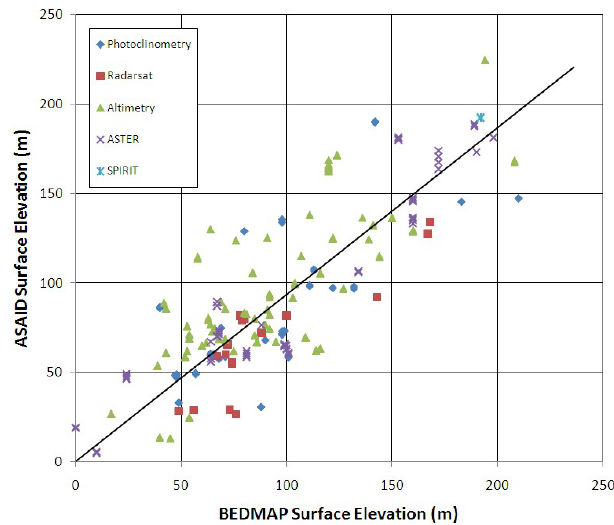
Figure 9. Surface elevations at common locations along the ASAID grounded ice boundary extracted Fig. 9. Surface elevations at common locations along the ASAID from BEDMAP missions versus preferred surface elevations selected from various DEMs by ASAID. grounded ice boundary extracted from BEDMAP missions ver- Data symbols identify the source DEM used by ASAID. Sloped line is a linear fit through all points constrained to pass through (0,0) (cf. Table 4). sus preferred surface elevations selected from various DEMs by ASAID. Data symbols identify the source DEM used by